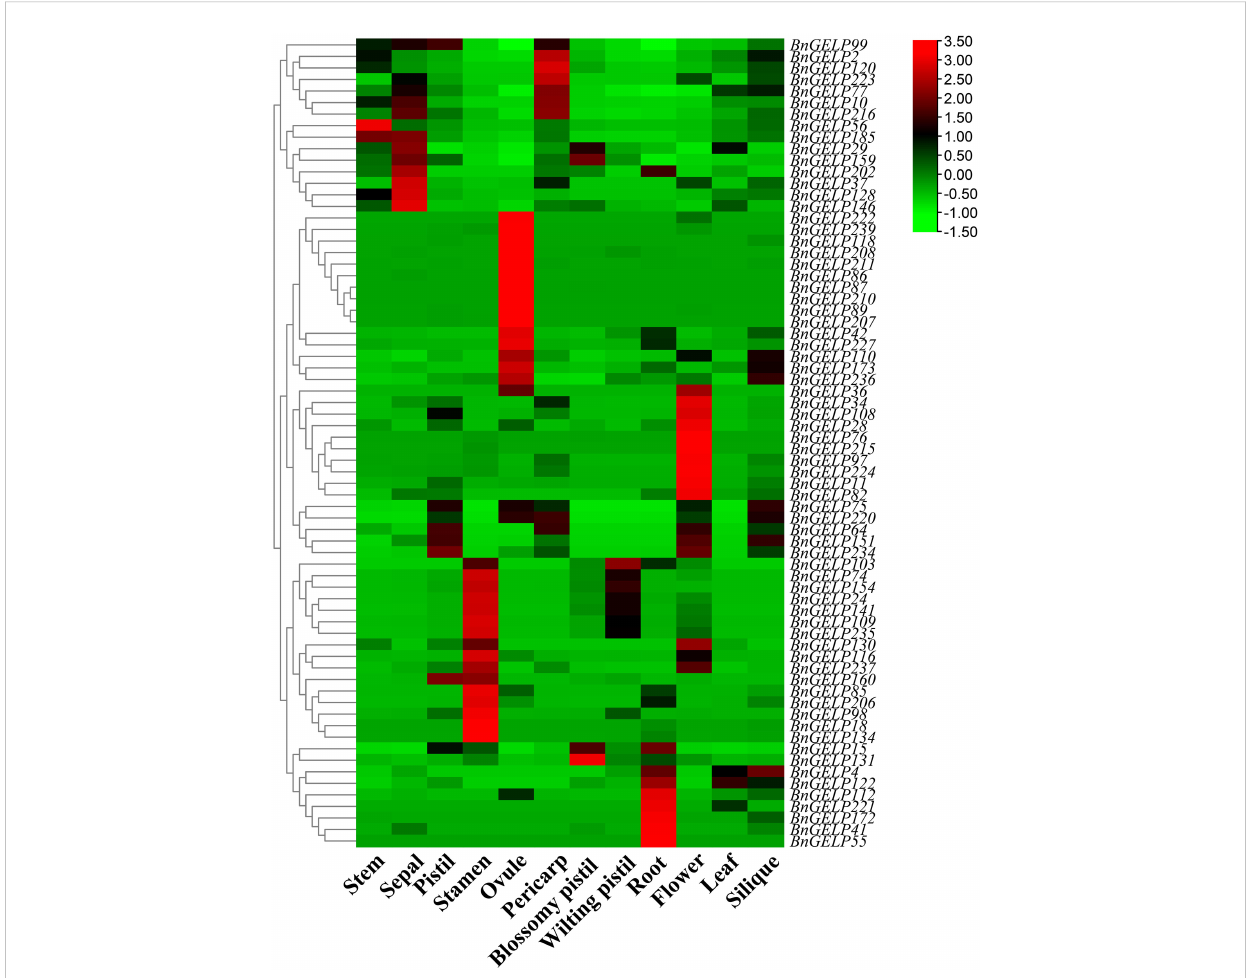
FIGURE 6 Expression pro fi les of the clade 5 BnGELP genes in different tissues. Transcript levels for the 70 BnGELP genes were obtained from public transcriptome data obtained from different tissues of B . napus cultivar ZS11. Each relative expression level is equal to the mean values and transformed log 2 values for normalization. The color scale represents relative expression levels from low (green colored) to high (red